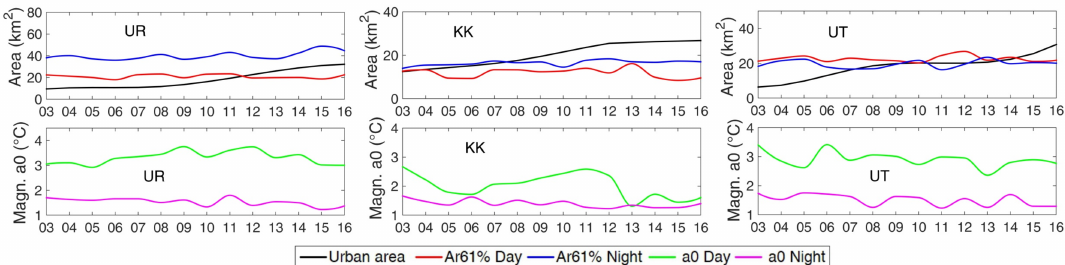
Figure 12. UR, KK, and UT yearly trend (2003–2016) of the urban area computed from LULC Landsat maps (black line, upper panel), daytime Ar61% (red line, upper panel), nighttime Ar61% (blue line, upper panel), daytime a0 (green line, lower panel), and nighttime a0 (magenta line, lower